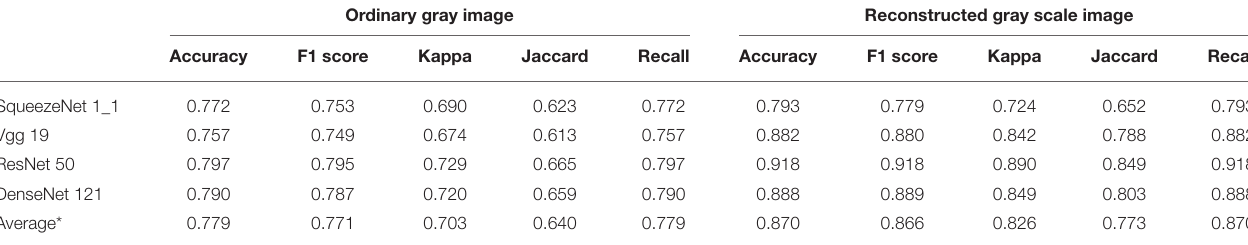
TABLE 2 | Comparison of performances before and after reconstructed gray scale image.